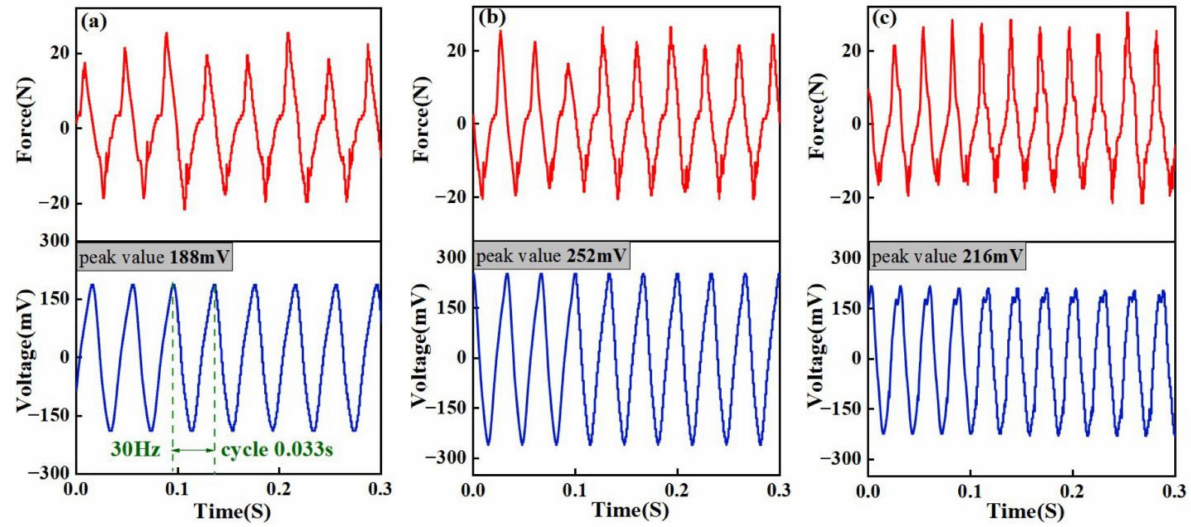
Figure 19. Input force and output voltage at different excitation frequencies. ( a ) 25 Hz; ( b ) 30 Hz; ( c ) 35 Hz.